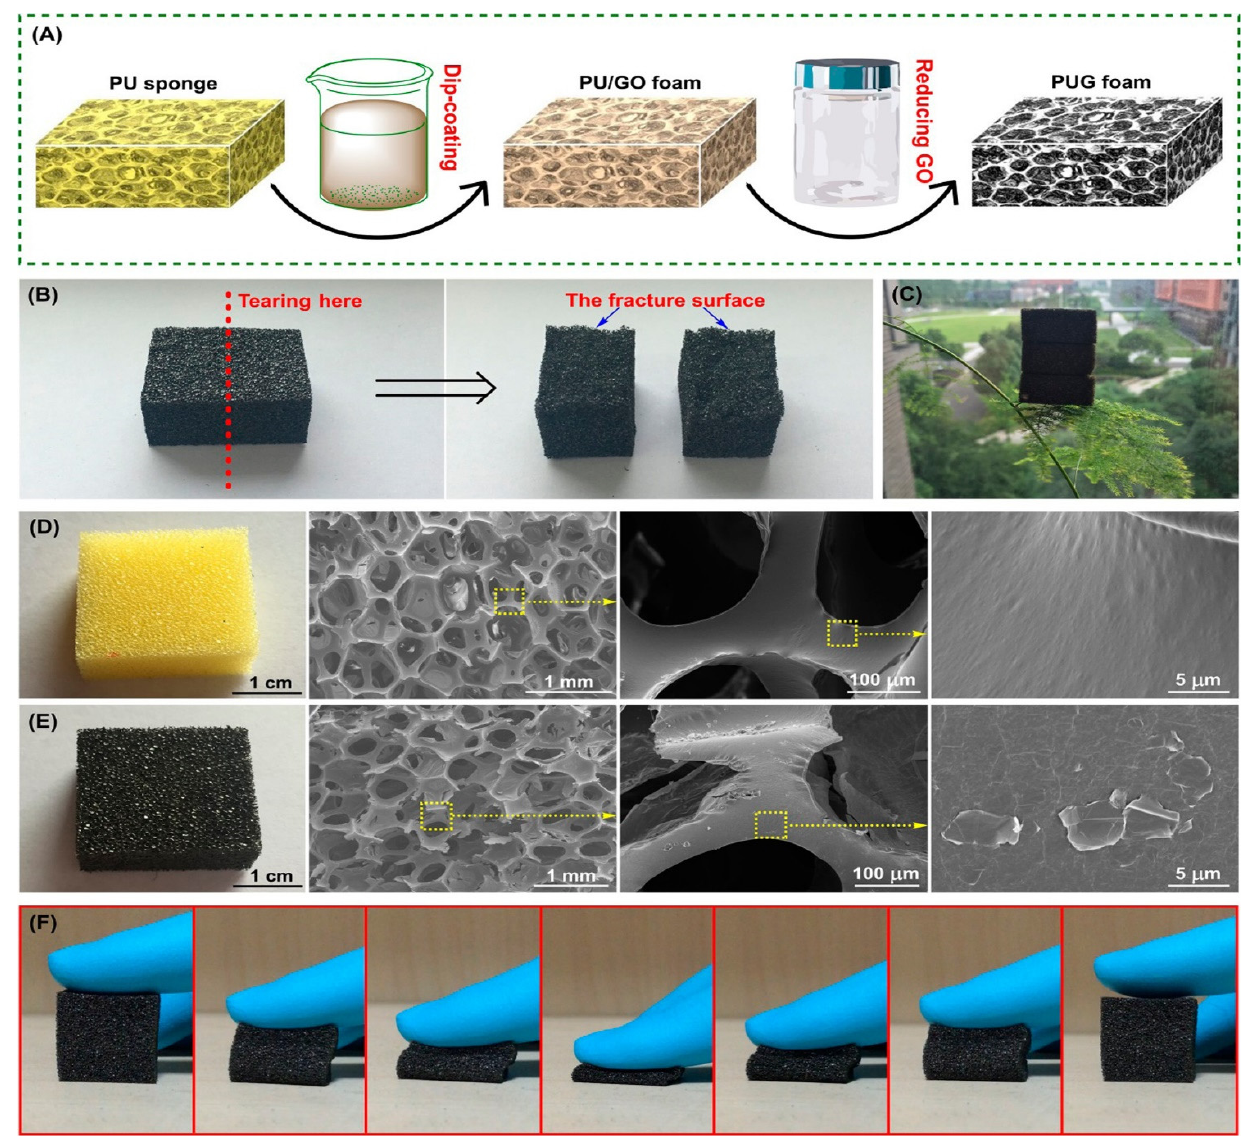
Figure 11. ( A ) Stepwise fabrication process of PU/graphene foams, including dip-coating GO sheets onto PU foams followed by hydrothermal reduction using hydrazine vapor. ( B ) A piece of foam showing uniform coating after being torn from the middle portion. ( C ) A block of foam on the leaf of an asparagus fern. ( D , E ) Optical and SEM images of pristine PU sponge and PU/graphene foam. ( F ) Compressing and releasing these foams depicting excellent compressibility and recovery. Re- produced with permission from [113]. Copyright 2016, American Chemical Society.